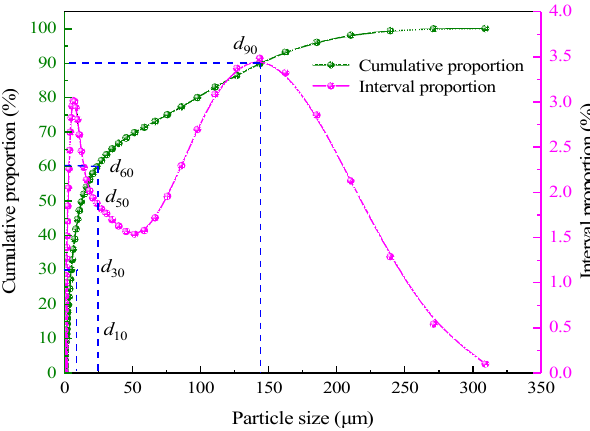
Figure 5. Particle size distribution curve of gasification slag.